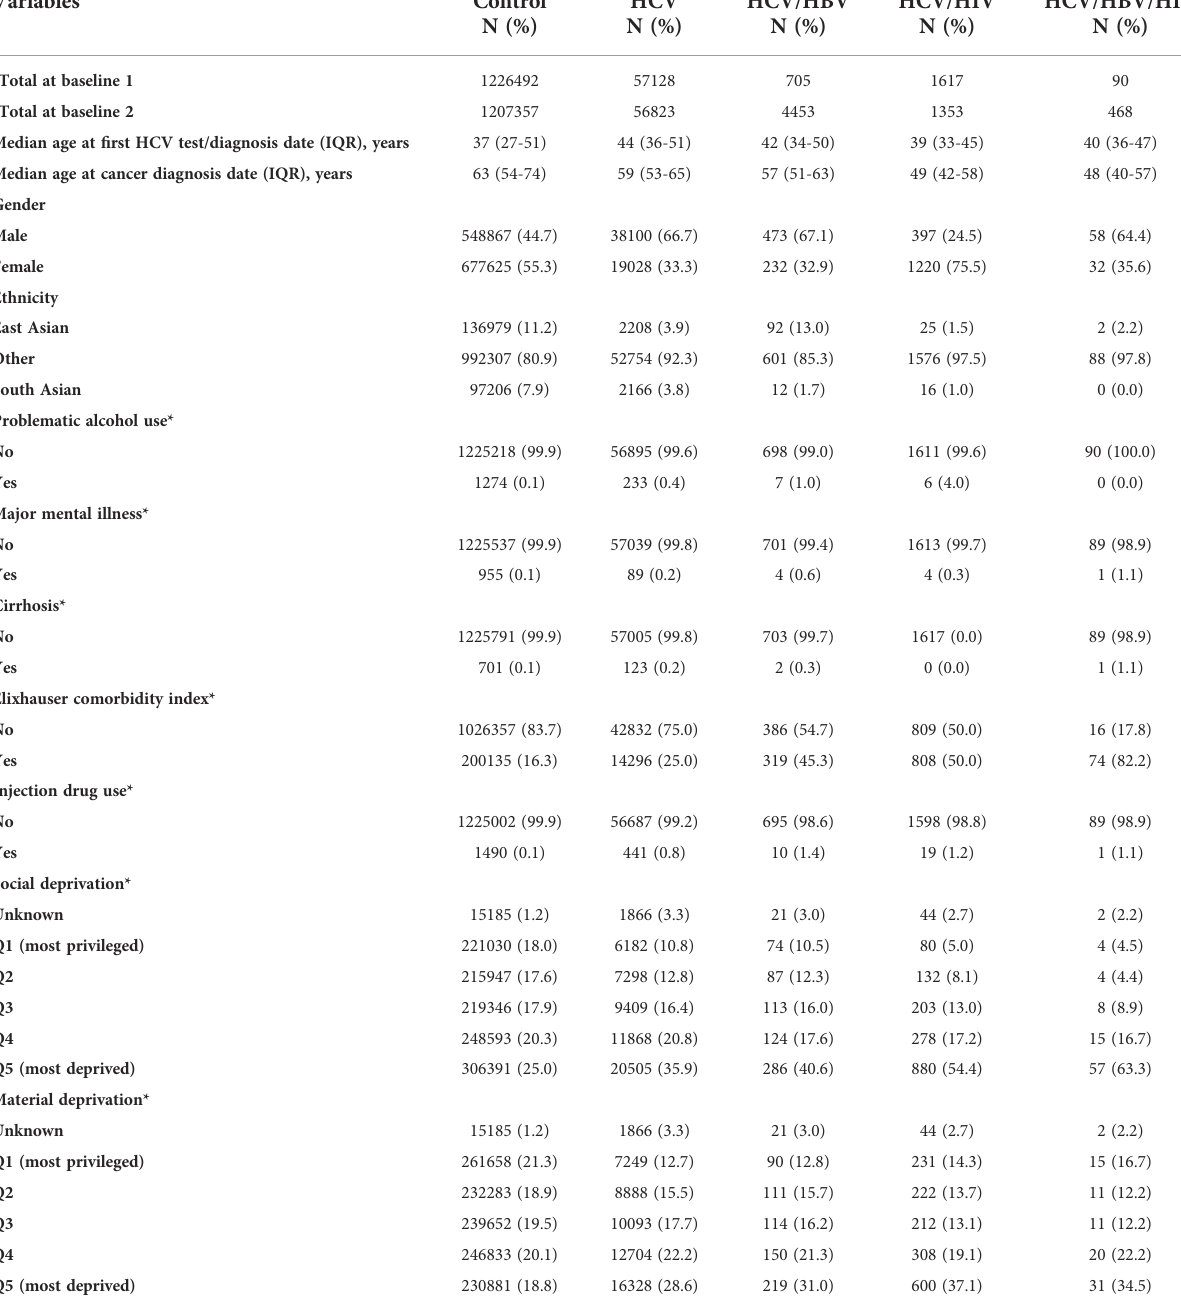
TABLE 1 Baseline characteristics of study participants in BC Hepatitis Testers Cohort, 1990-2015.